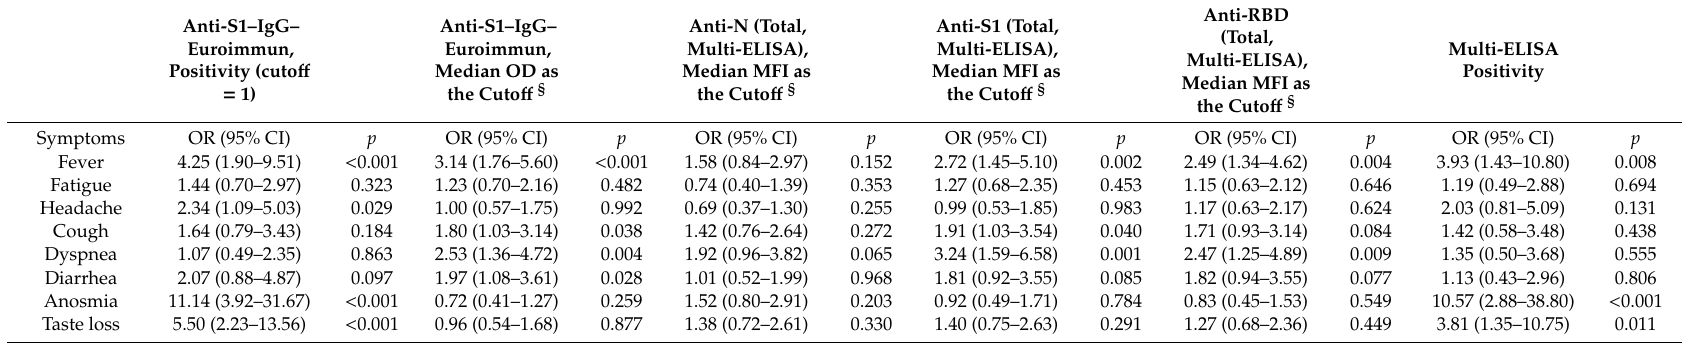
§ In these logistic regression models, serum antibody levels were converted to a binary dependent variable, based on the median value of the sample (0: ≤ median, 1: > median). Median values were: 5.47 for anti-S1–IgG–Euroimmun; 53,799 for anti-N; 45,036 for anti-S1 (multi-ELISA); and 42,753 for anti-RBD (multi-ELISA). MFI: mean fluorescence intensity; OD: optical